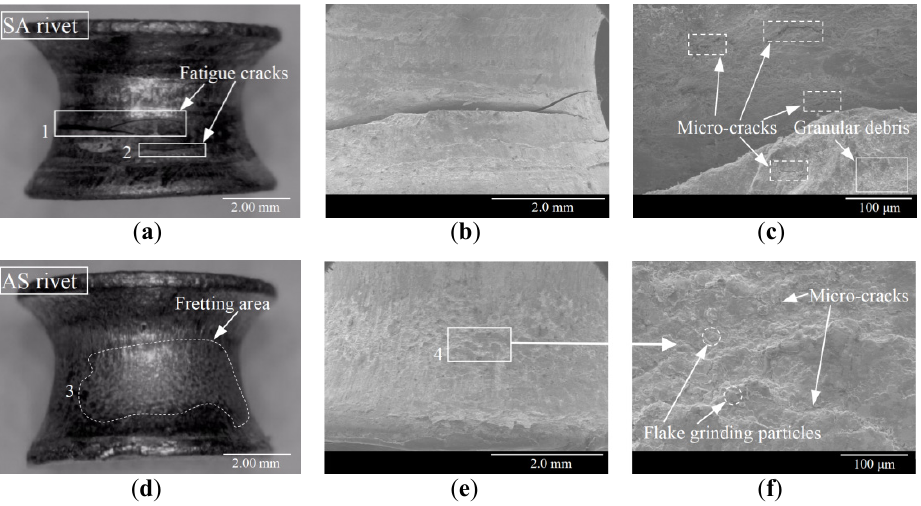
Figure 13. Micro-morphologies of the SA rivet and AS rivet. ( a ) SA rivet; ( b ) cracks of area 1; ( c ) micro-cracks of area 2; ( d ) AS rivet; ( e ) fretting wear of area 3; ( f ) micro-cracks of area 4.